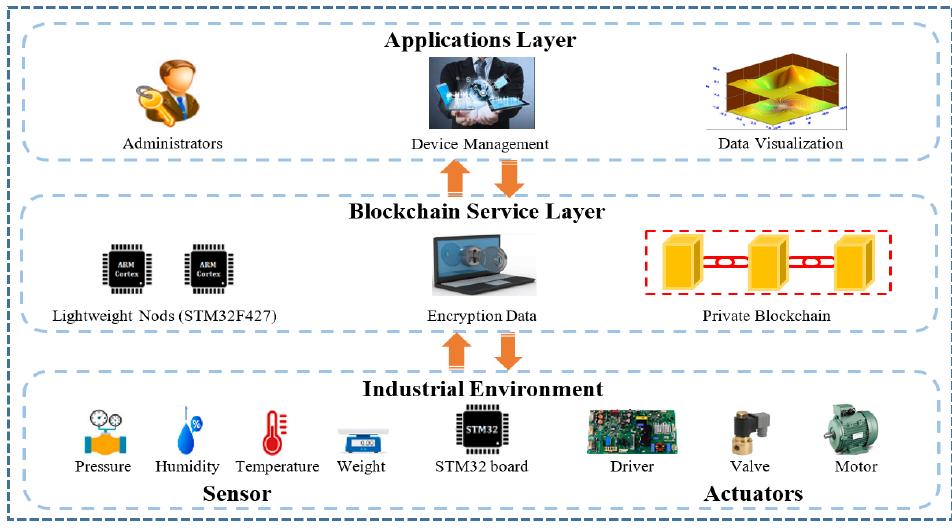
Figure 1. Blockchain architecture for